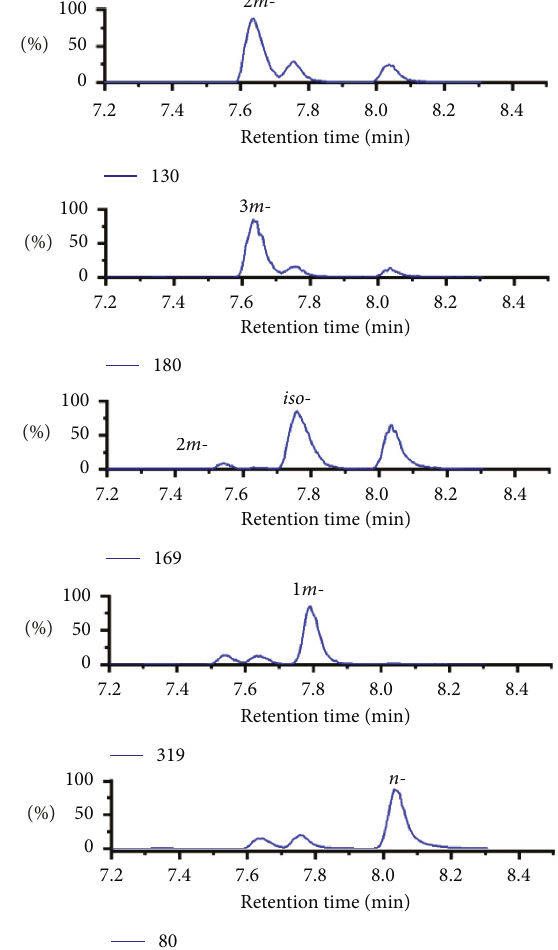
Figure 4: Identification of the isomers in the standard based on the observed specific series of product ions produced from the mo- lecular ion m/z 399 under MRM